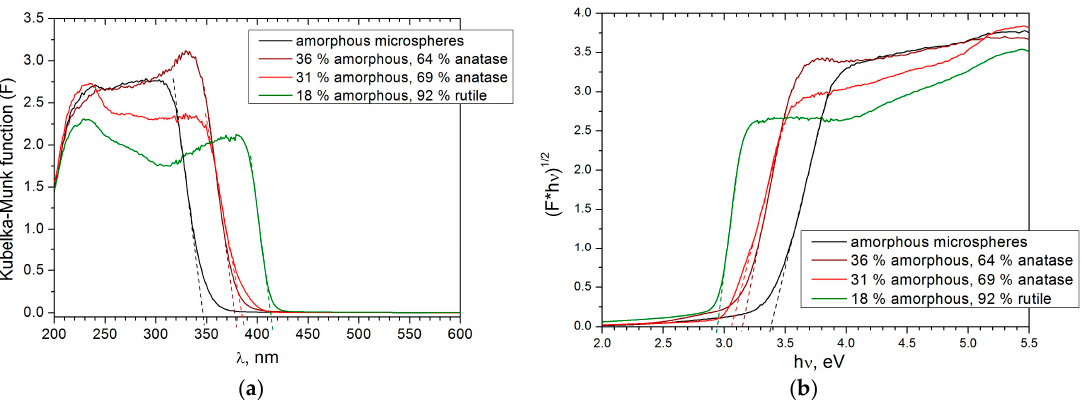
Figure 10. The optical absorption edges ( a ) and band-gap calculation ( b ) of amorphous, predominantly anatase, and predominantly rutile microspheres. The absorption edges of anatase-containing microspheres have similar positions, whereas for the rutile and amorphous phase, they differ significantly.